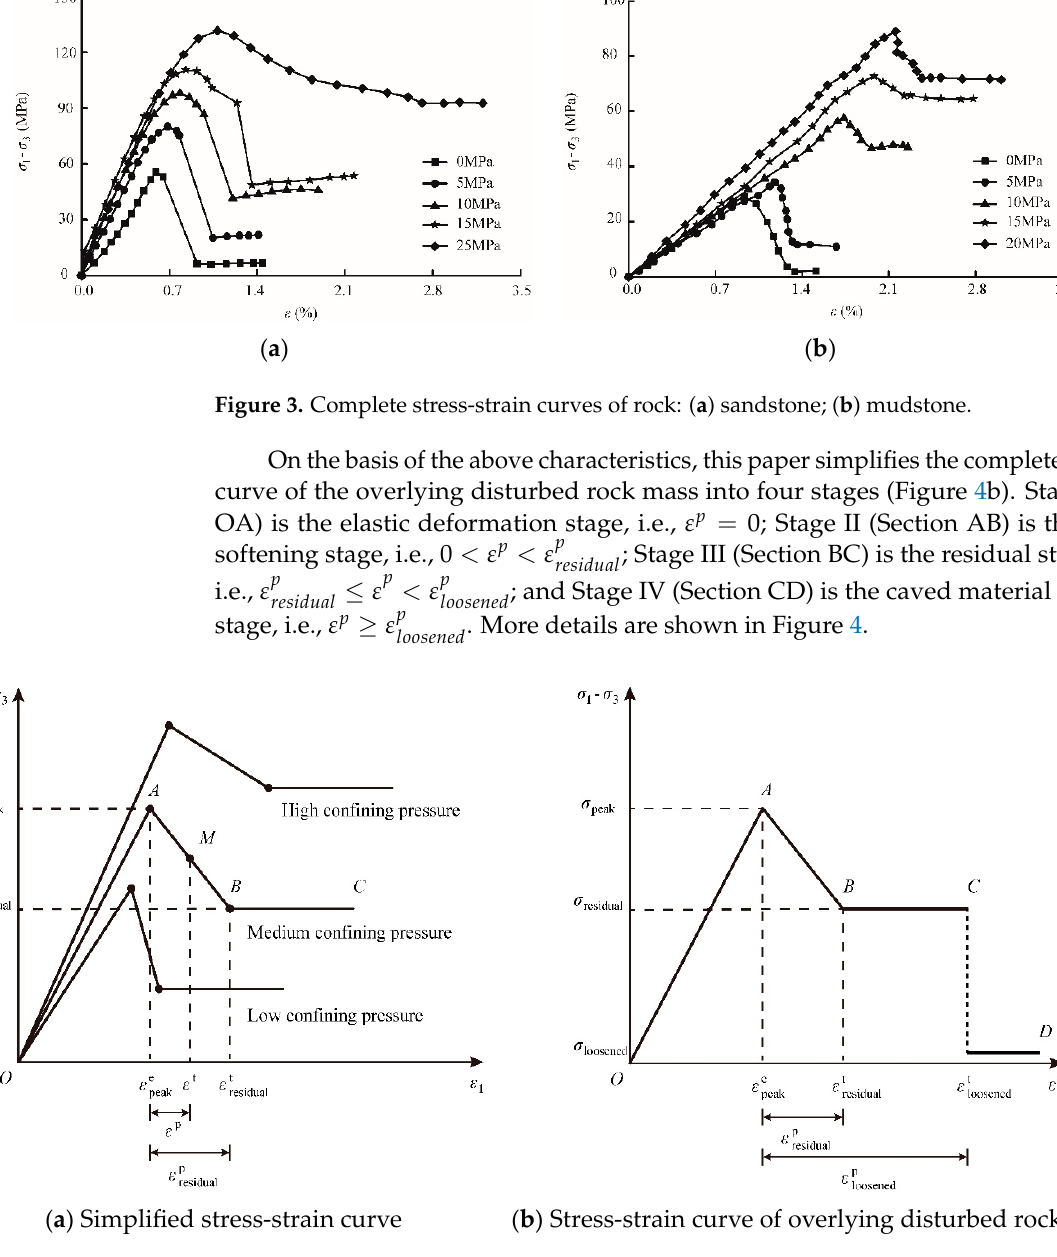
Figure 4. The simpli fi ed complete stress ‒ strain curve of the rock mass.